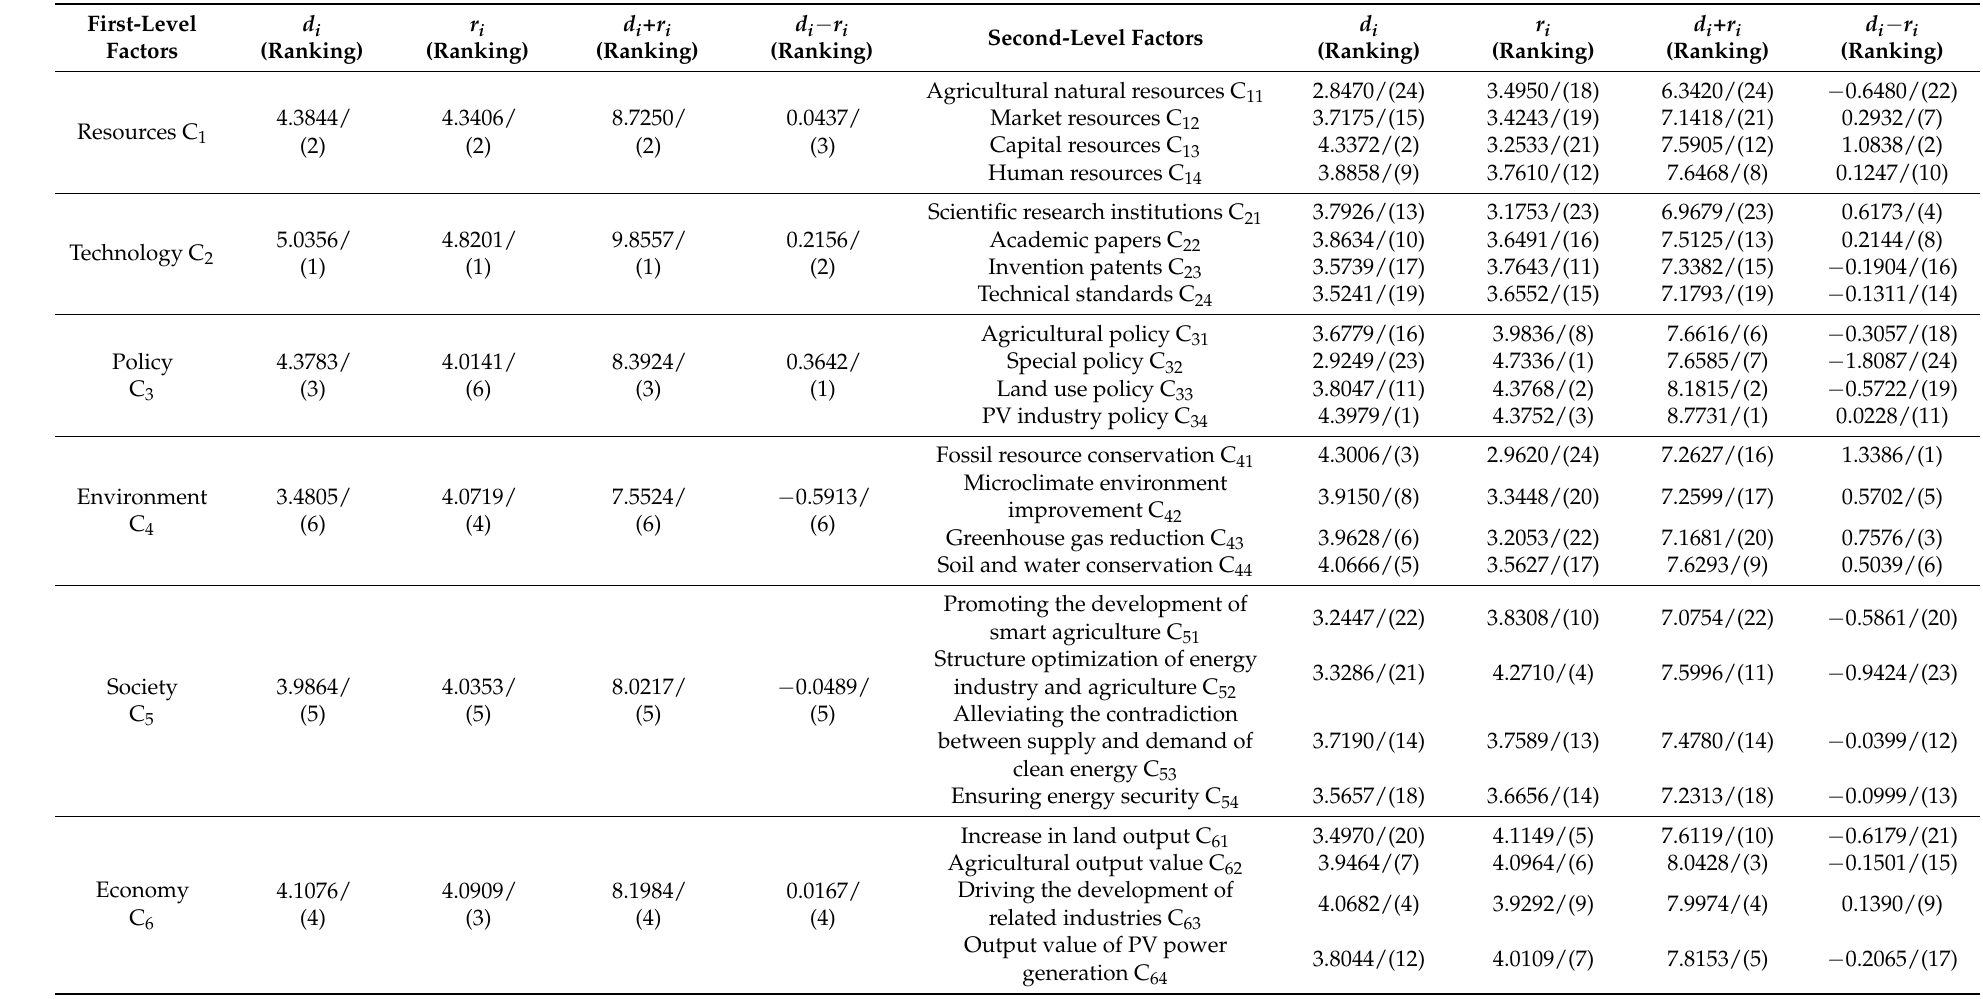
Table 5. Centrality and causality of influencing